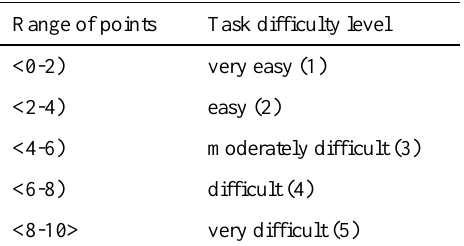
The assumed categories of the task difficulty